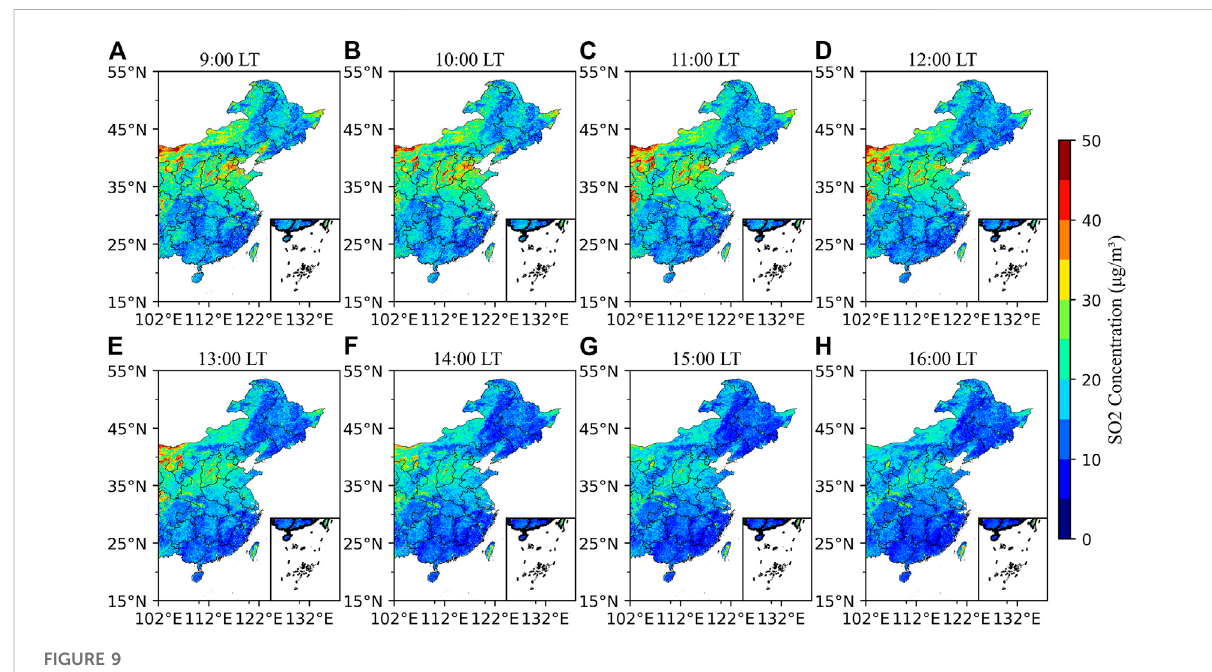
FIGURE 9 The intraday variation of SO 2 concentration predicted by the model ( μ g/m 3 ).